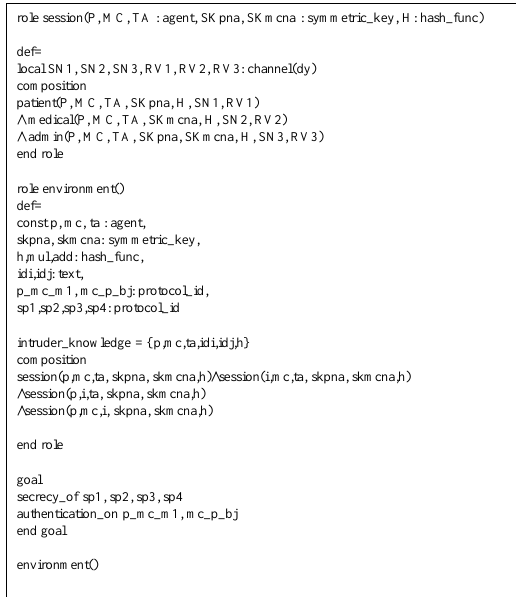
Figure 11. HLPSL syntax of network administrator.